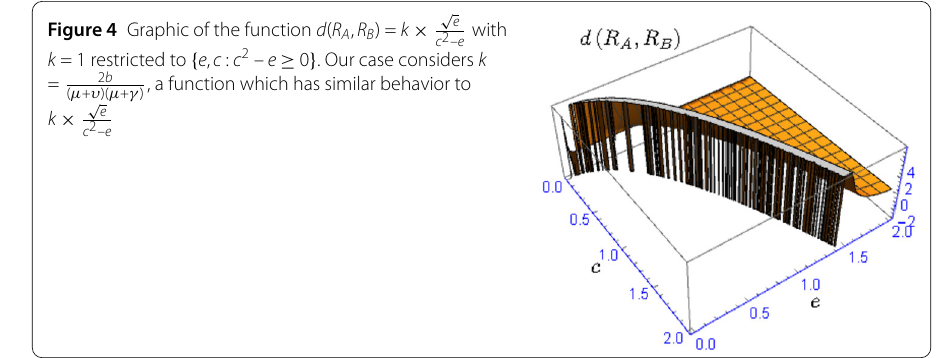
Figure 4 Graphic of the function d ( R A , R B ) = k ×